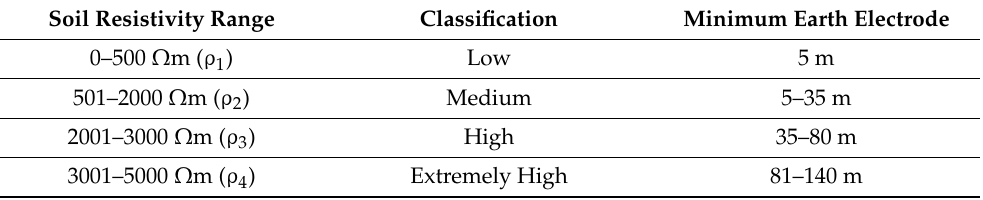
Table 5. Classification of soil resistivity range and calculation of minimum earth electrode.